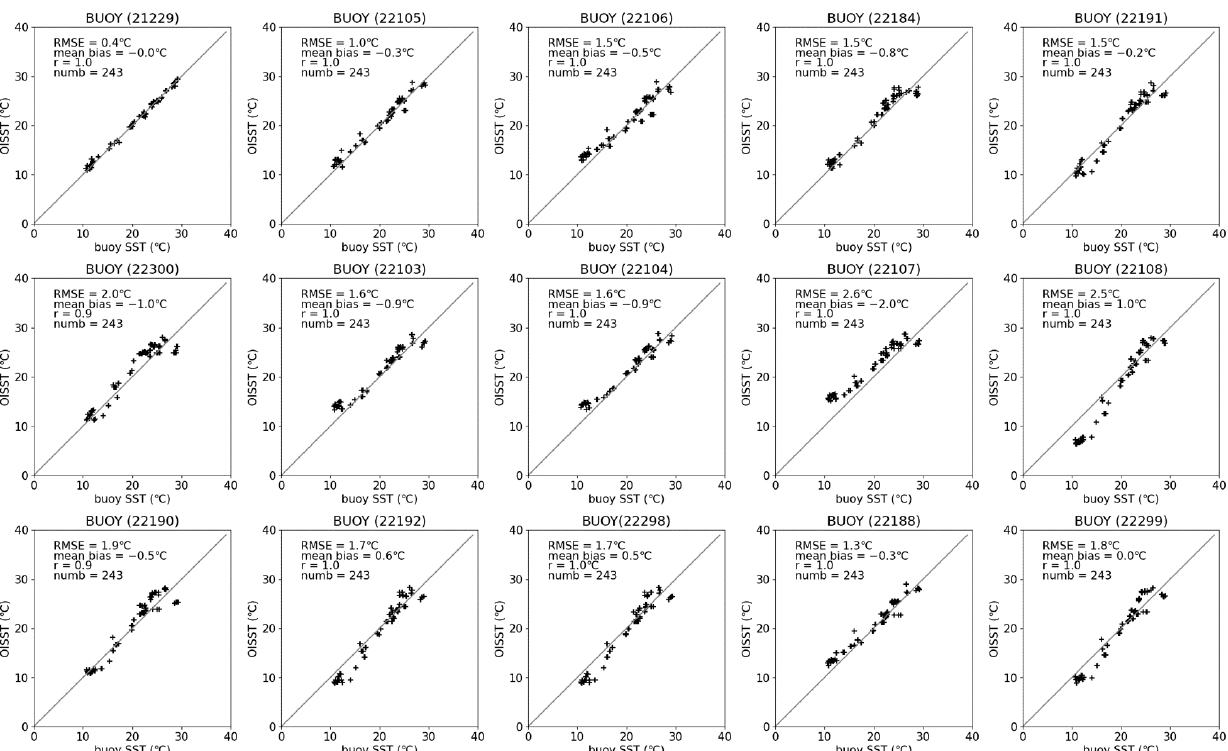
Figure 2. Comparison of OISST with the SST from buoys operating in the WS, ES, and SS of Korea.